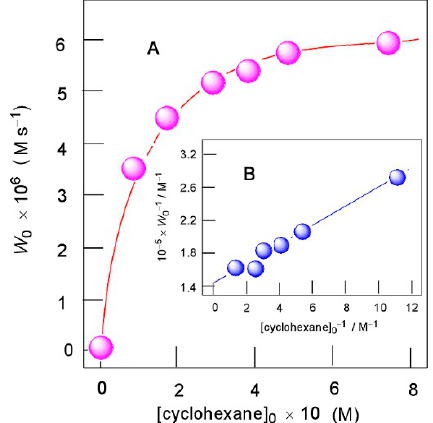
Figure 18. Oxidation of cyclohexane with H 2 O 2 (1.0 M) catalyzed by compound 2 (3.2 × 10 − 5 M) in the presence of HNO 3 (0.04 M) in MeCN at 50 °C. Graph A : dependence of the initial rate of oxygenate formation W 0 on initial concentration of cyclohexane. Graph B : anamorphosis of curve shown in Graph A in coordinates [cyclohexane] 0 − 1 – W 0 − 1 . Adapted from Ref. [160].